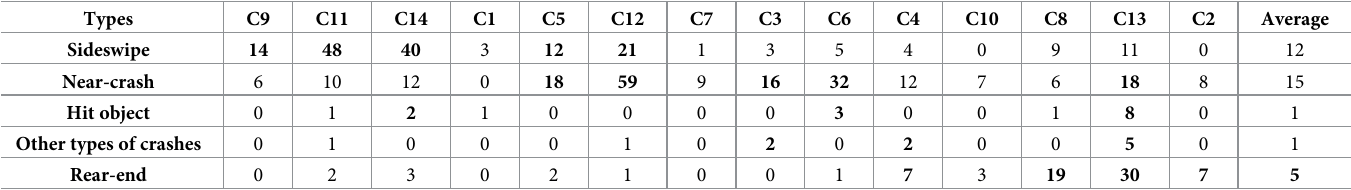
Table 4. The corresponding relationship table between crash types and unsafe behaviors.